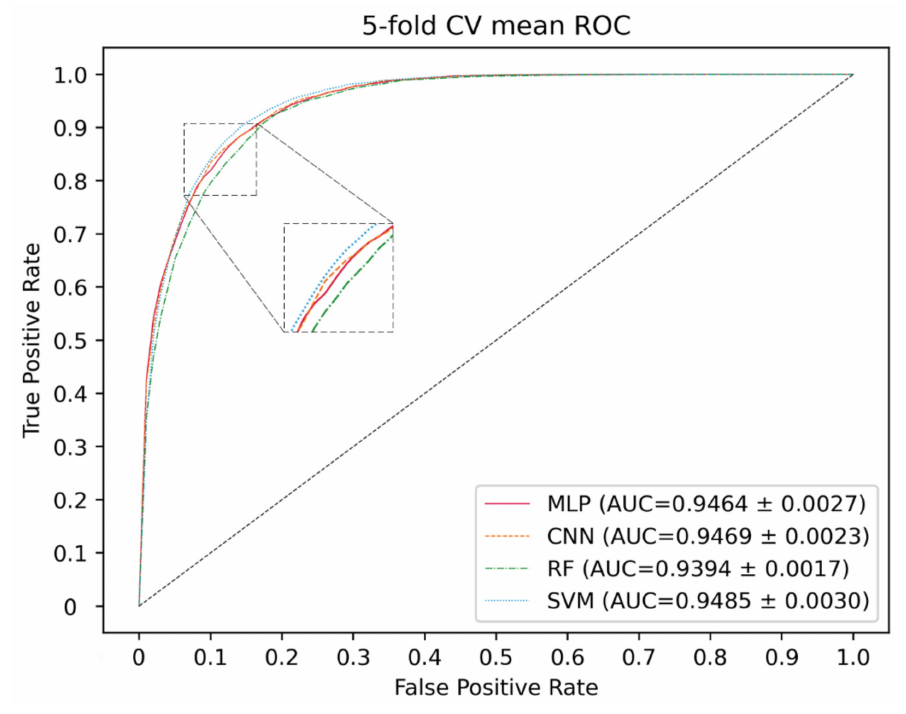
Figure 3. ROC curves for different classifier.